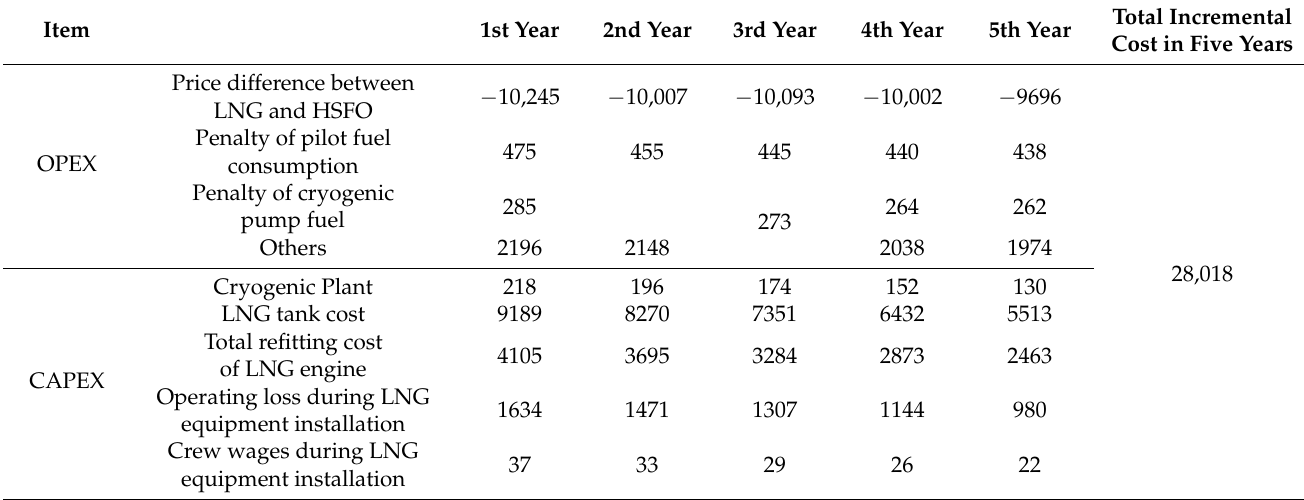
Table 12. Total incremental costs of Vessel B. Unit: